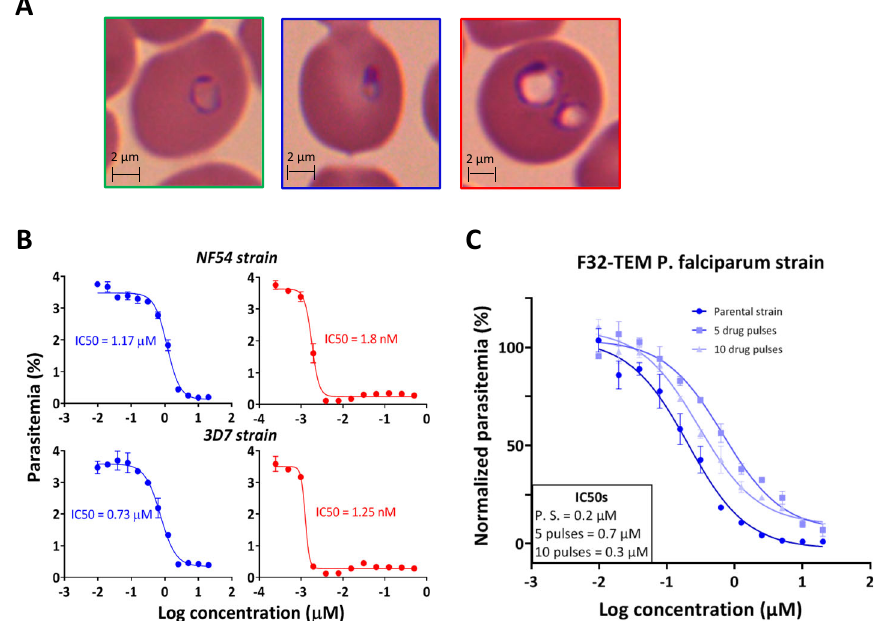
Fig.5|ActivityofNITD609andTD-6450onasexualparasites.A Giemsa-stained erythrocytes infected by a ring-stage of P. falciparum exposed to DMSO (negative control, green border), TD-6450 5 µ M (blue border) and NITD609 1 µ M (red bor- der).Theopticalmicroscopicobservationswererepeated5times. B Dose-response of synchronized ring-stage P. falciparum (NF54 and 3D7 pULG8-GFP